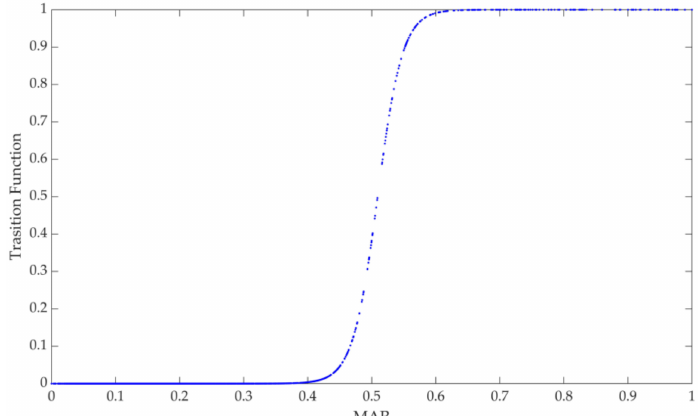
Figure 3. Transition function figure of